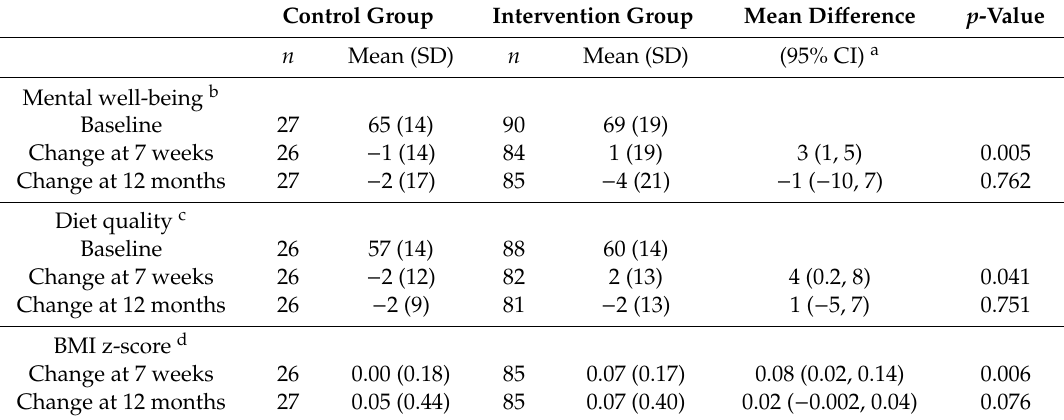
Table 2. E ff ect of the COOK intervention on BMI z-score, diet quality, and mental well-being at 7 weeks and 12 months ( n = 118).